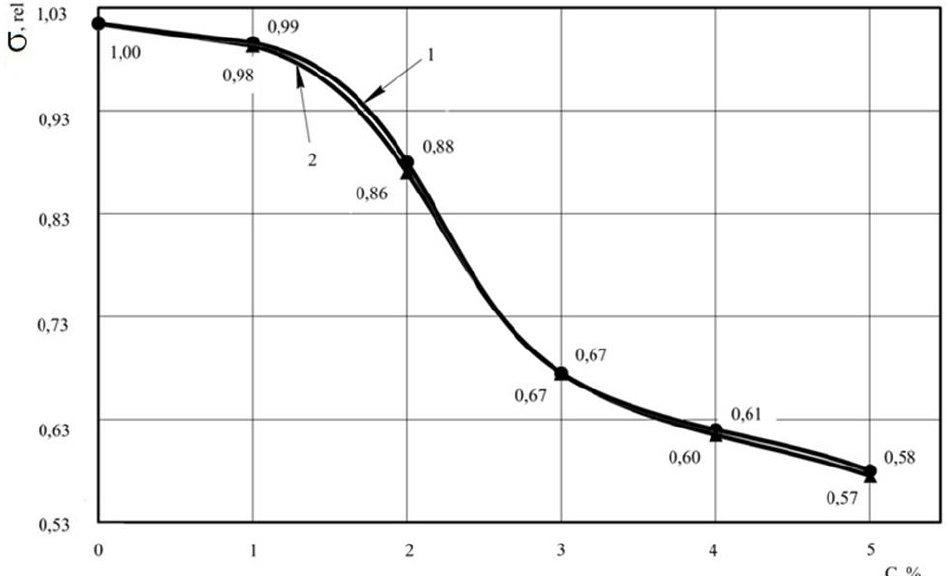
Figure 6. Dependence of the relative strengths (  concentration ( C ) of peat-based organic additive (1: bog peat; 2: fen